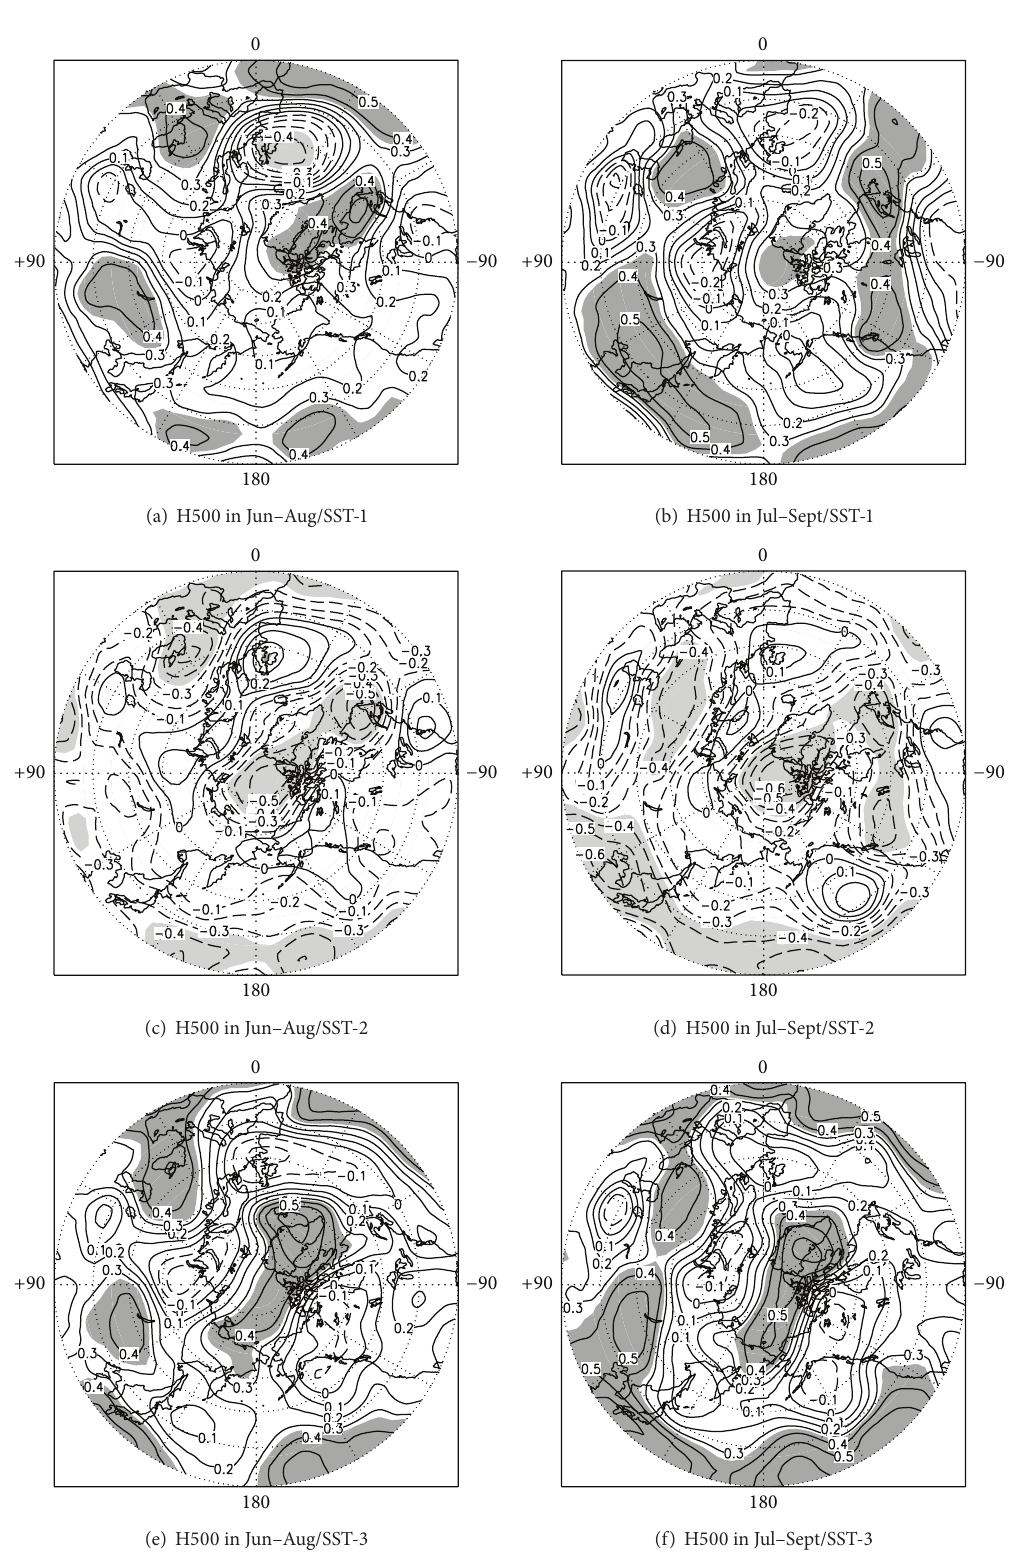
Figure 12: The correlation distribution between surface sea temperature (SST) indices in spring (MAM) and 500 hPa height (H500) in summer (JJA and JAS): (a) SST index in central North Pacific (30 ∘ –50 ∘ N, 160 ∘ E–160 ∘ W) and H500 in JJA, (b) as in (a) but for H500 in JAS, (c) SST index in eastern North Pacific (20 ∘ –30 ∘ N, 120 ∘ –150 ∘ W) and H500 in JJA, (d) as in (c) but for H500 in JAS, (e) SST index in midlatitudes over Atlantic (25 ∘ –35 ∘ N, 20 ∘ –45 ∘ W) and H500 in JJA, and (f) as in (e) but for H500 in